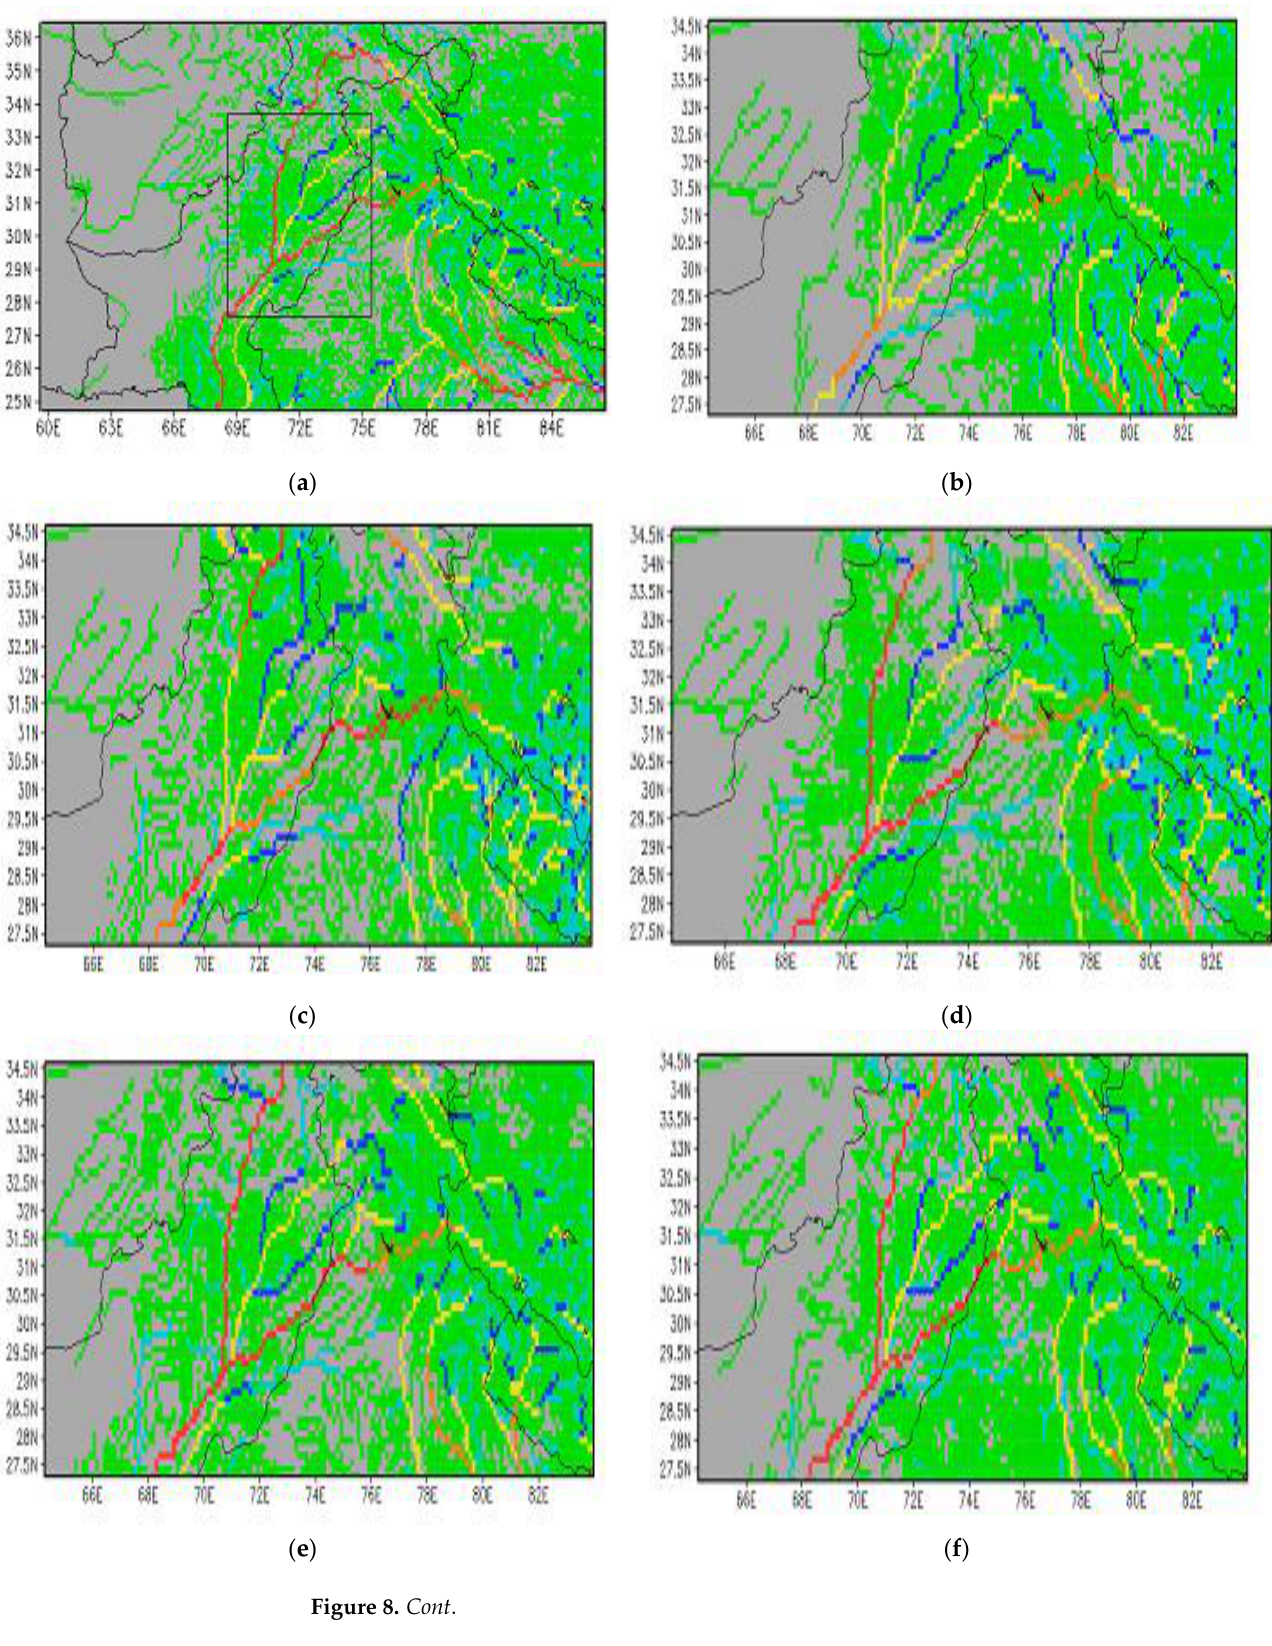
Figure 7. The monthly flood streamflow (above flood threshold) events time series at 3 h intervals over five weather stations (21Z01Jan2010 to 21Z31Dec2010): ( a ) FSD 1, ( d ) 2 FSD stations located in the south, ( b ) LHR located in the northeast, ( c ) MLN 1 in the center of the plain, and ( e ) MLN 2, also located in the center of the plain.